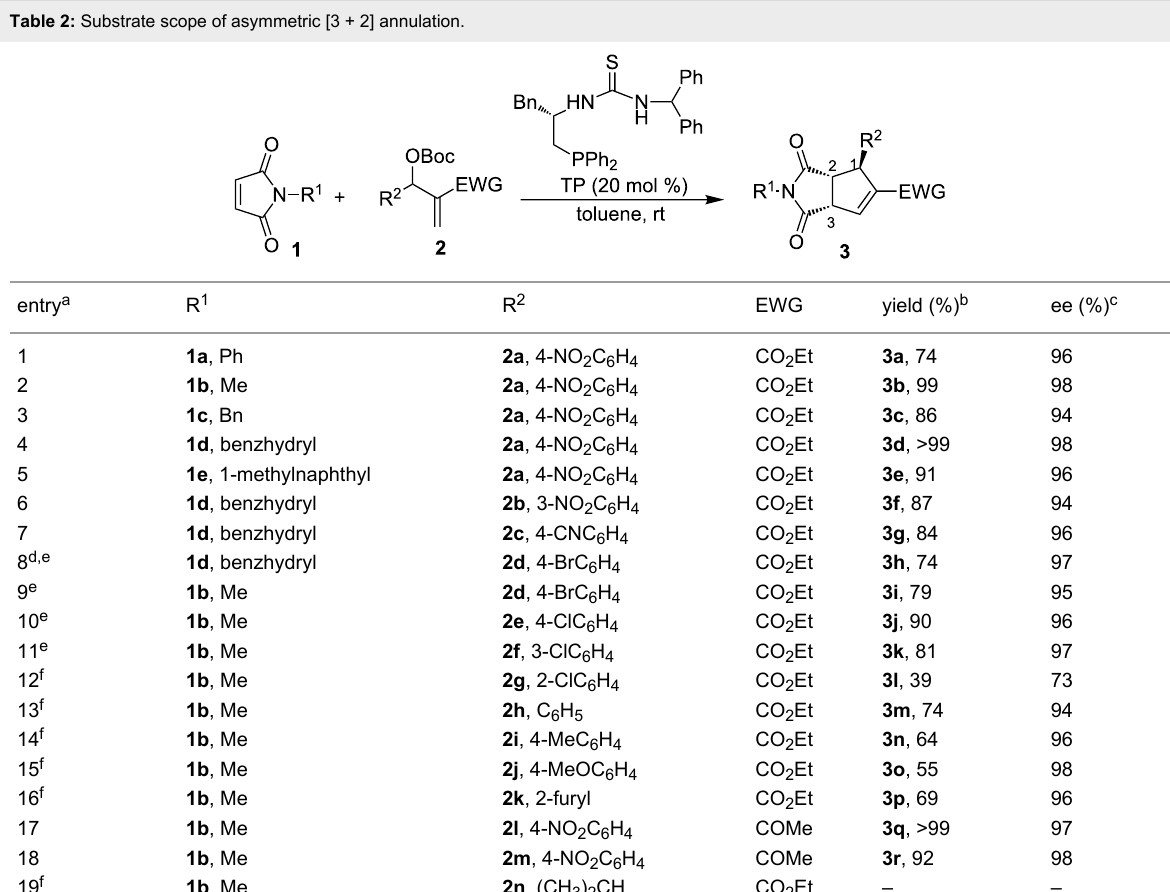
Table 2: Substrate scope of asymmetric [3 + 2]